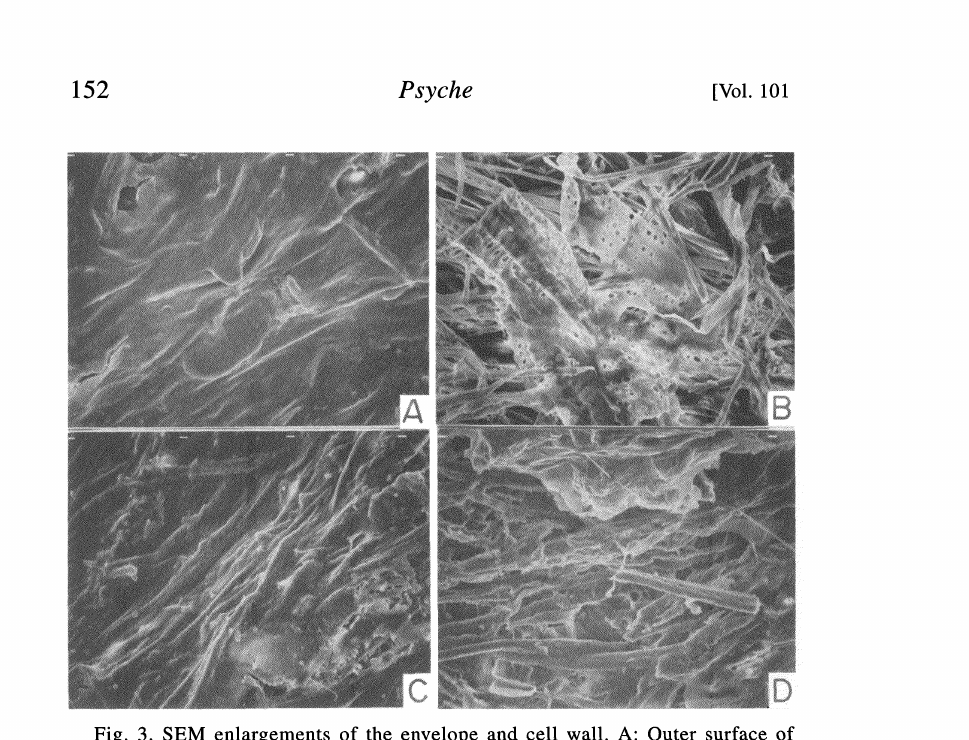
Fig. 3. SEM enlargements of the envelope and cell wall. A: Outer surface of envelope from an arboreal nest, B: Same as A. Salivary coat was removed to expose fibrous structure. C: Surface of cell wall, and D: Same as C,